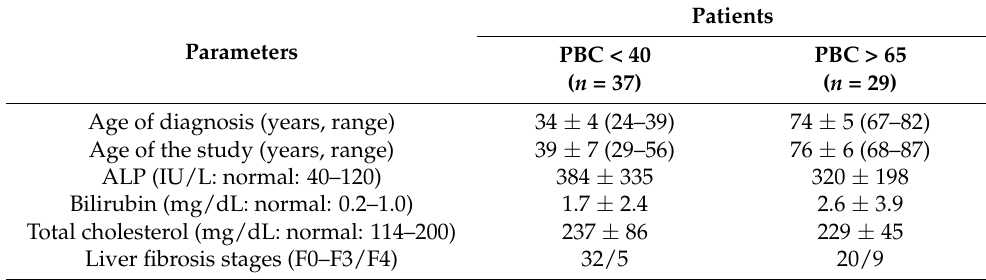
Table 2. Baseline clinical characteristics of analyzed PBC patients (mean ± SD).